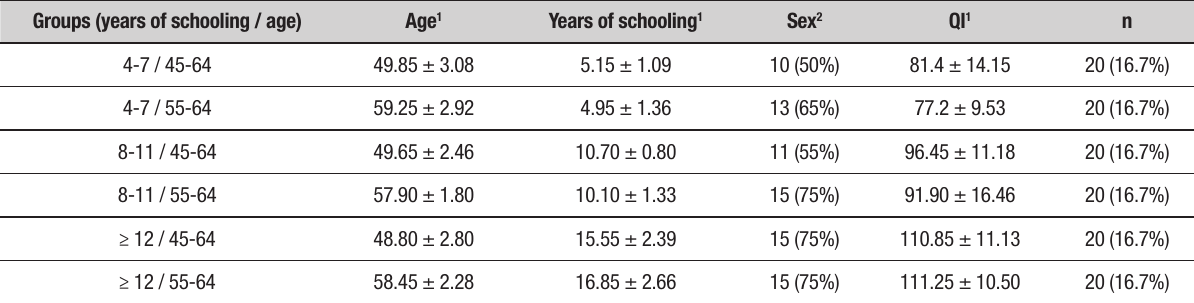
Table 1. Description of participants. Groups (years of schooling / age) Age 1